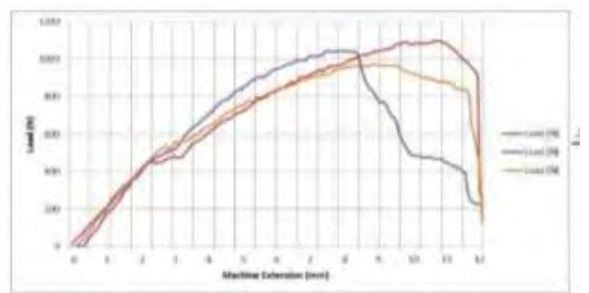
Figure 38. Graphs of the apparent Modulus of Elasticity of span 280 mm (Author’s own, n.d.)